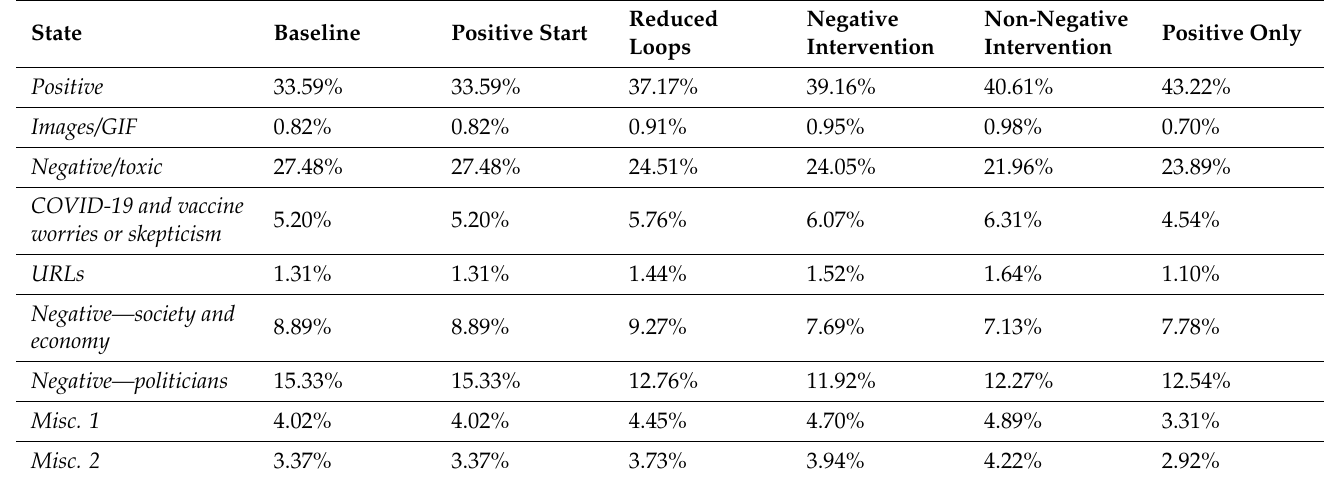
Table 4. Probability of comments from each state for every moderation